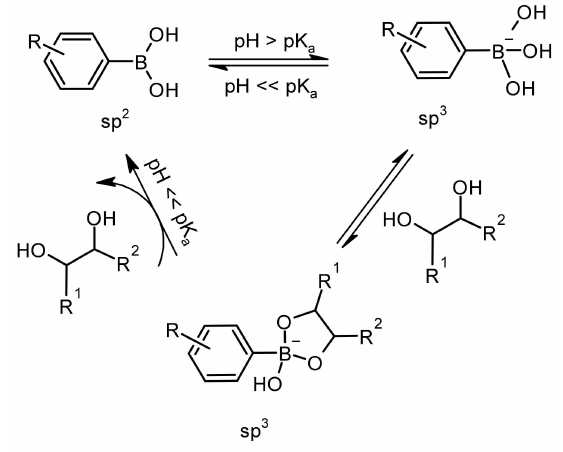
Figure 4. Interactions between the phenylboronic acid derivative and compounds containing cis-diol groups (scheme based on the work of Liu et al.